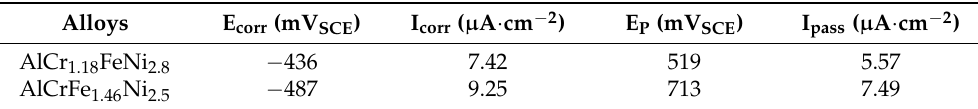
Table 4. Electrochemical parameters of AlCr 1.18 FeNi 2.8 and AlCrFe 1.46 Ni 2.5 alloys specimens in 3.5 wt.% NaCl solution.